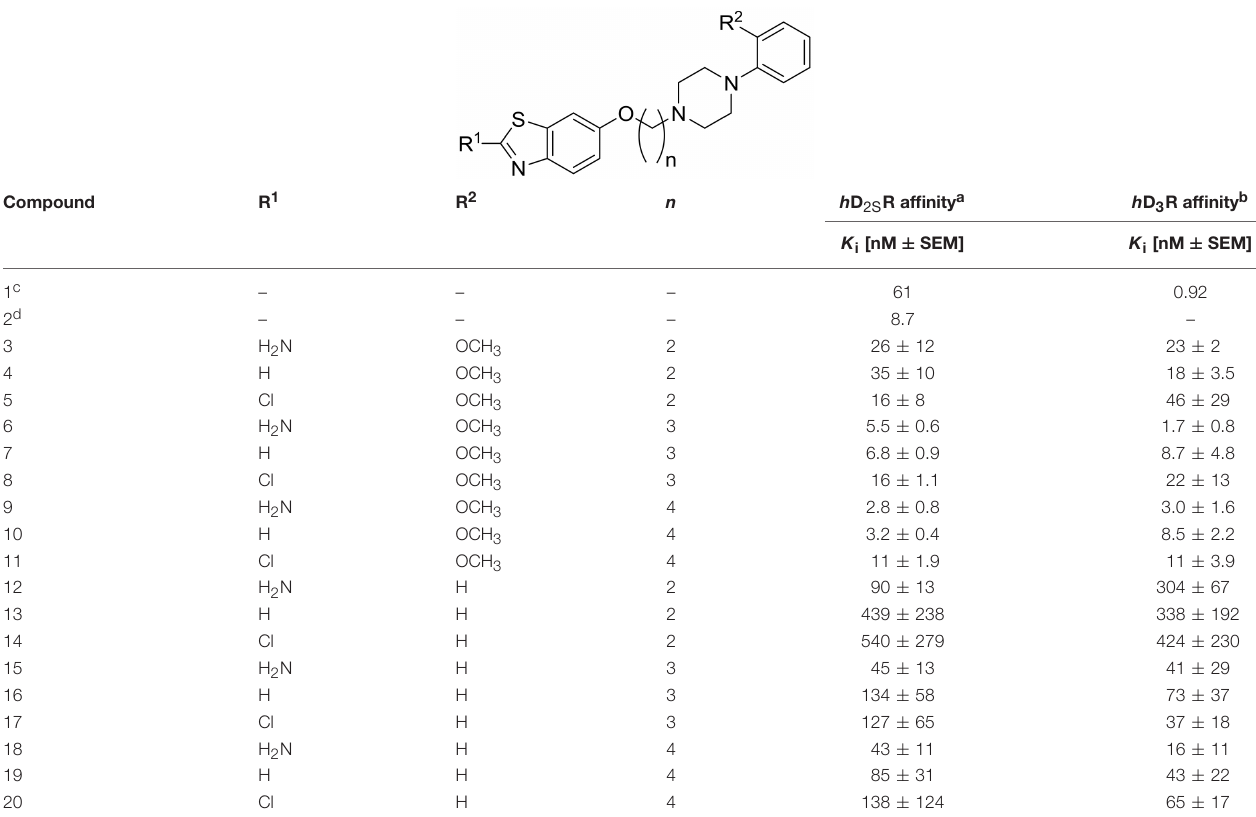
TABLE 1 | Dopamine h D 2S R and h D 3 R binding affinities of ligands 1 , 2 and final products 3-20 .